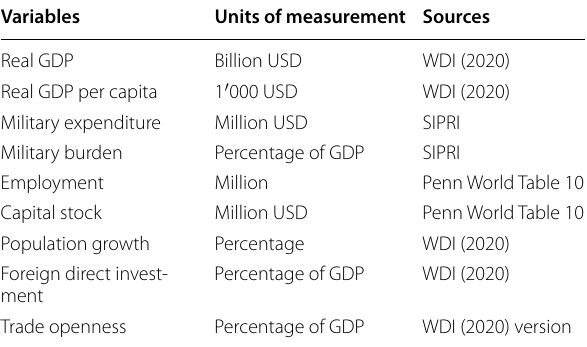
Table 1 Variables, units of measurement and sources Source